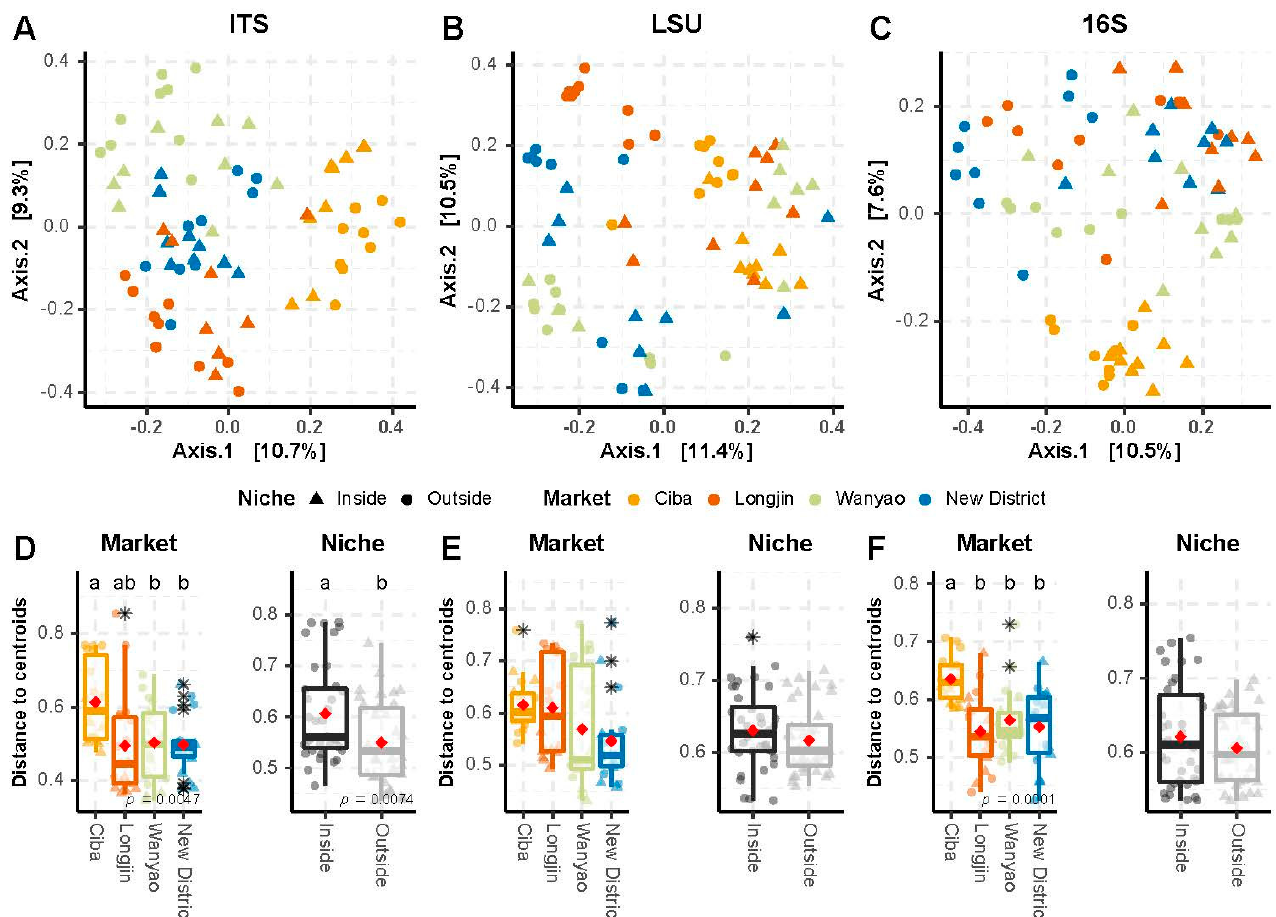
Figure 2. Principal coordinate analysis (PCoA) ordinations and sample distance from group centroids (dispersion) distributions for the two factors assesses (market and niche). Model significance was tested using ANOVA-like permutation test (permutations = 9999) and p -values adjusted using the Bonferroni method. Letters, when present, represent pairwise permutation tests. Data are shown for ITS ( A , D ), LSU ( B , E ) and 16S ( C , F ) rDNA markers. Outliers are marked with an asterisk (*). Red diamonds represent the mean of the distribution.